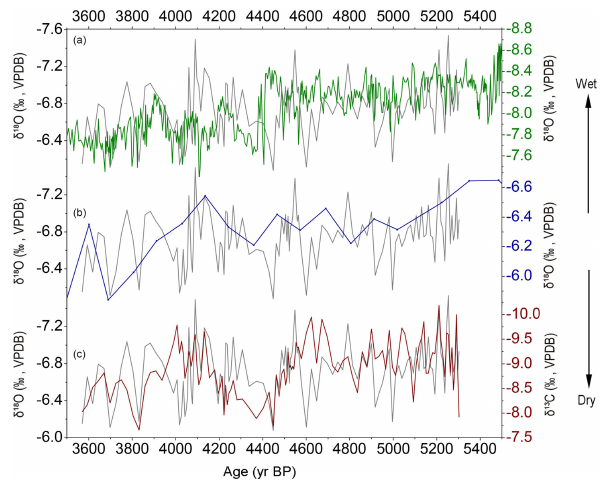
Figure 6. Replication of the δ 18 O records from three caves (Shen- nong Cave: gray lines, Dongge Cave: green line, Xiangshui Cave: dark blue line) during the overlapping growth period and compar- ison between δ 18 O (gray line) and δ 13 C (brown line) records of SN17